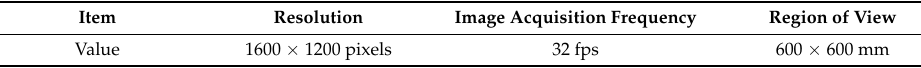
Table 2. The detailed information of the charge-coupled device camera.